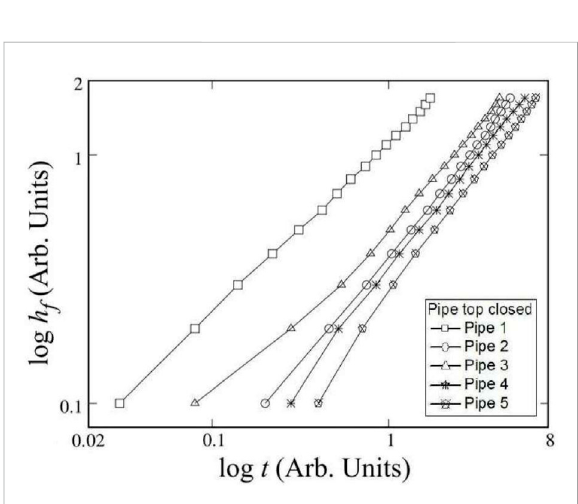
FIGURE 6 Logarithm of the foam height in meters versus the logarithm of time in seconds for the same data of Figure 5.